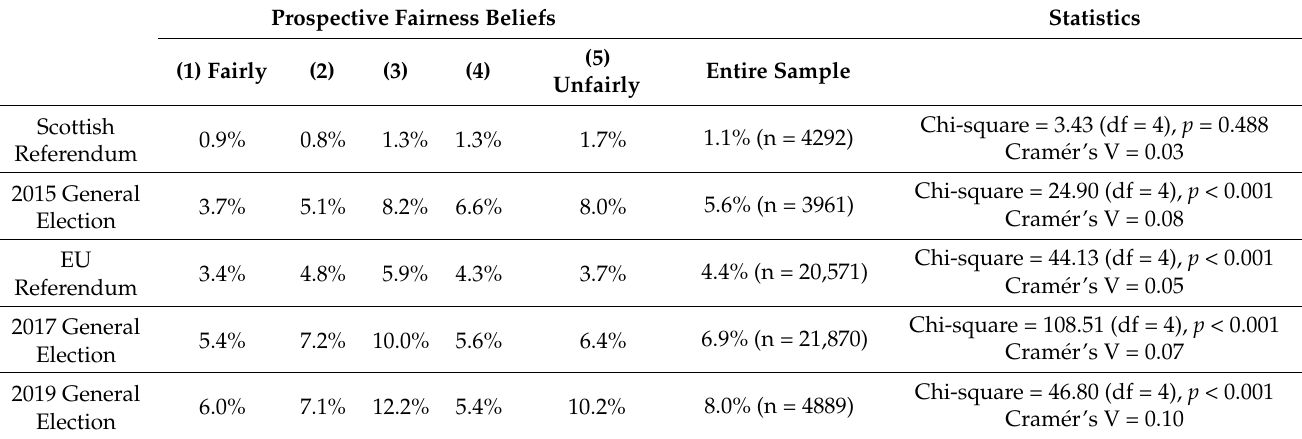
Table 5. Non-voting and electoral fairness beliefs (percentages non-voting per response category of fairness